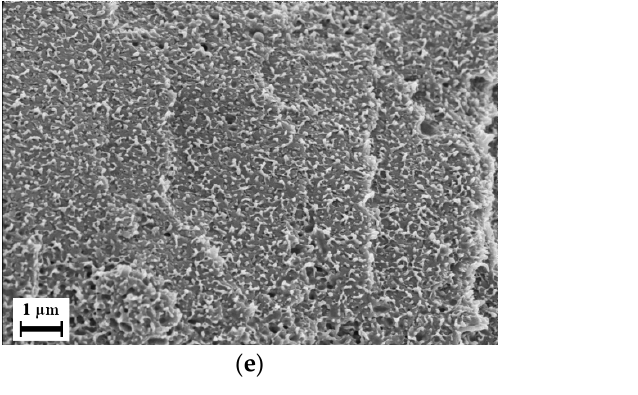
Figure 10. Scanning electron micrographs of sandwich-type samples manufactured using method I, batch foamed and post-treated: ( a ) Cross section of blend H-8; ( b ) Microstructure observed in the skin layer from figure ( a ); ( c ) Cross section of blend H-32; ( d ) microstructure observed in smaller green box and commonly found across the area enclosed by larger green boxes in figure ( c ); ( e ) Observed solid structure in the smaller red box and commonly found across the area enclosed by the larger red box in figure ( c ); ( f ) Outer surface of blend H-32.